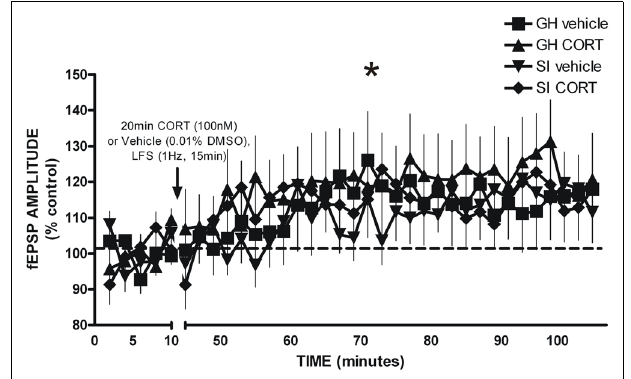
FIGURE 8 | LFS-induced long-term potentiation of glutamatergic field excitatory postsynaptic potentials (fEPSP) amplitude in the BLA of GH and SI rats. There was a significant main effect of time, such that significant potentiation of fEPSP amplitude was observed post-LFS. * p < 0.05 post-LFS vs. baseline and drug